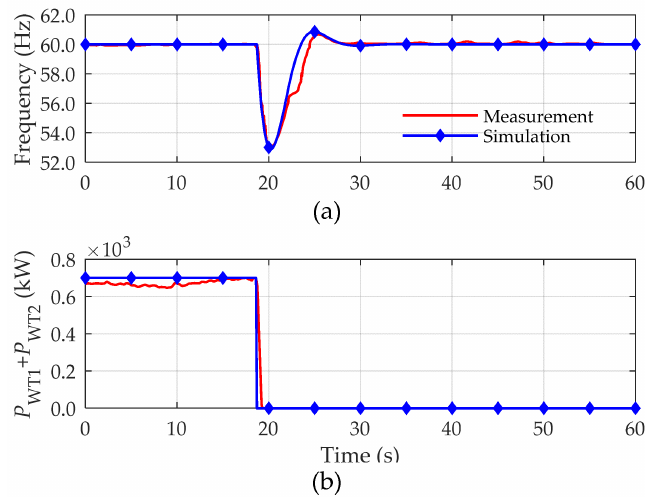
Figure 6. SCHPS model validation: ( a ) Grid frequency; ( b ) Wind farm generated